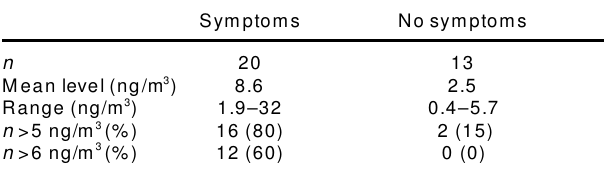
Table 4. Airborne levels of (1 ® 3)- b - D -glucan in buildings inhab- ited by people with and without symptoms